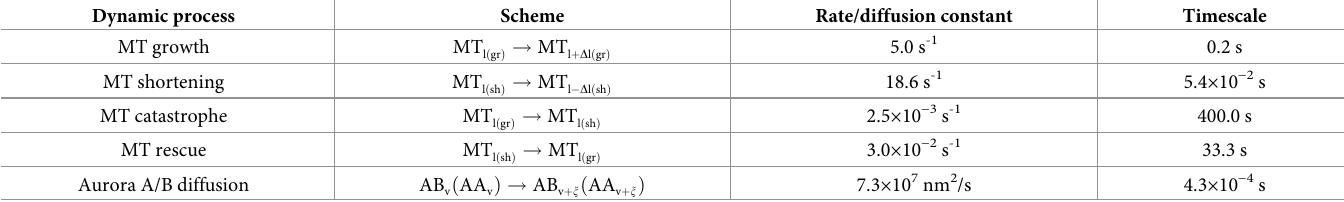
Table 3. Microtubule dynamic processes and transport properties of Aurora A and Aurora B enzymes. Dynamic processes involving microtubules (MT) and the val- ues of kinetic rate constants and characteristic timescales associated with the MT growth, shortening, catastrophe and rescue; Δ l = 24 nm is the amount by which MT length increases or decreases when MT grows or shortens, respectively. Also shown are the diffusion constants and diffusion timescales for Aurora B and Aurora A